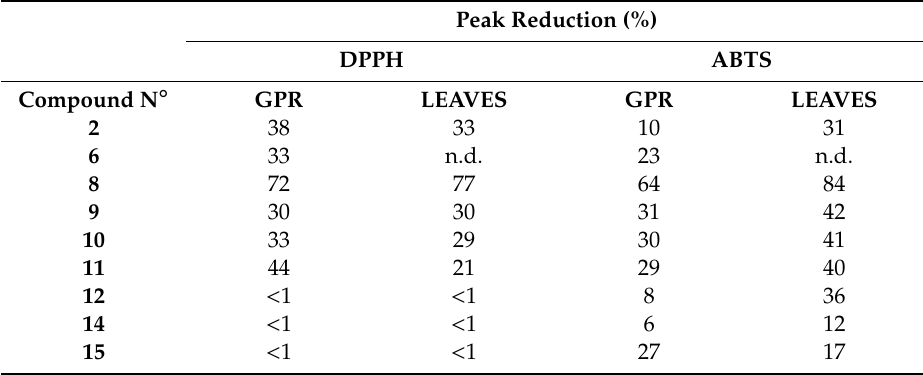
Table 2. Percent peak area reduction of nine markers of green pruning residues (GPRs) and leaves after the reaction with the ABTS + • and DPPH • radicals (n.d. = not detected). For the compound number, see Table